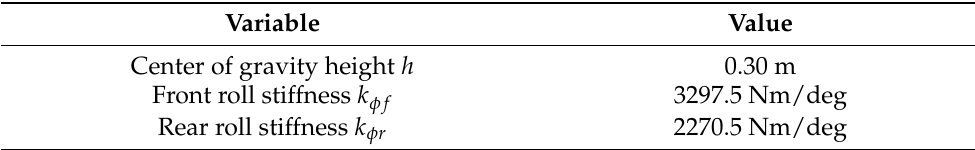
Table 2. Parameters chosen for the baseline